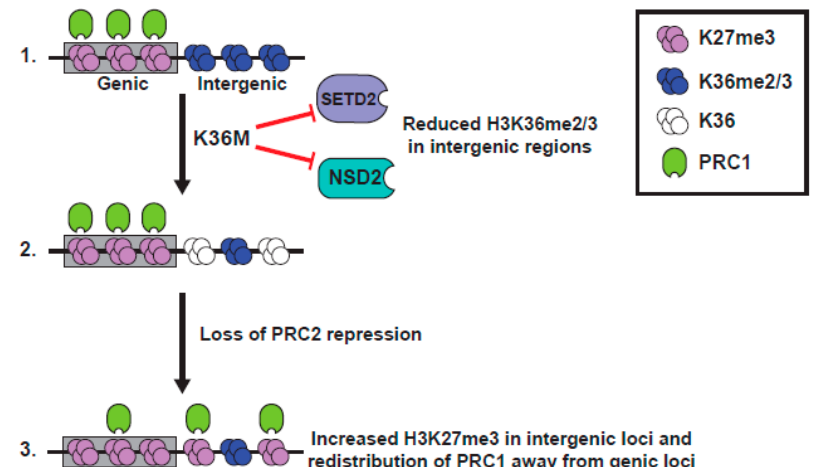
Figure 4. Model representing K36M mutant H3 function. Model derived from [11,93]. (1). K36M blocks function of SETD2 and NSD2, leading to reduction of K36me2/3. (2). In intergenic loci, reduction of H3K36me2 alleviates repression of PRC2, leading to increased intergenic K27me3. (3). Intergenic K27me3 recruits PRC1 away from genes, alleviating transcriptional silencing.